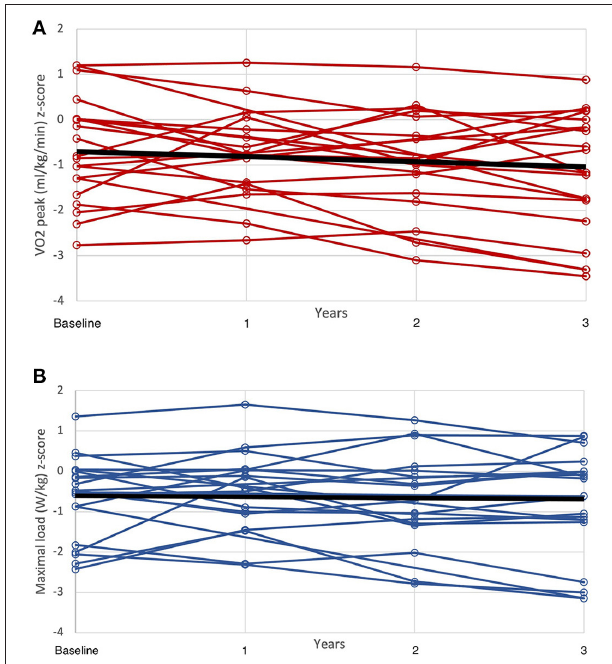
FIGURE 2 | (A) Development of maximal oxygen consumption (VO 2max /kg z-score) during the 3-year follow-up. (B) Development of maximal load (watt/kg z-score) during the 3-year